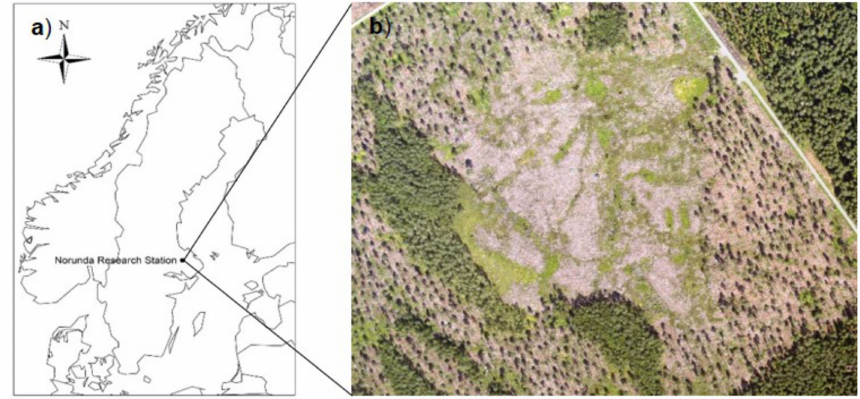
Figure 1. Location of the ICOS Sweden station Norunda (60 ◦ 5 (cid:48) N, 17 ◦ 29 (cid:48) E) in central Sweden ( a ) and the clear-cut in the close vicinity of the Norunda station where the study took place ( b ). The forest was harvested in 2009 and measurements started at the new clear-cut in May 2010 following soil scarification and planting. The aerial photograph was captured in 2011 during an airborne LiDAR campaign.